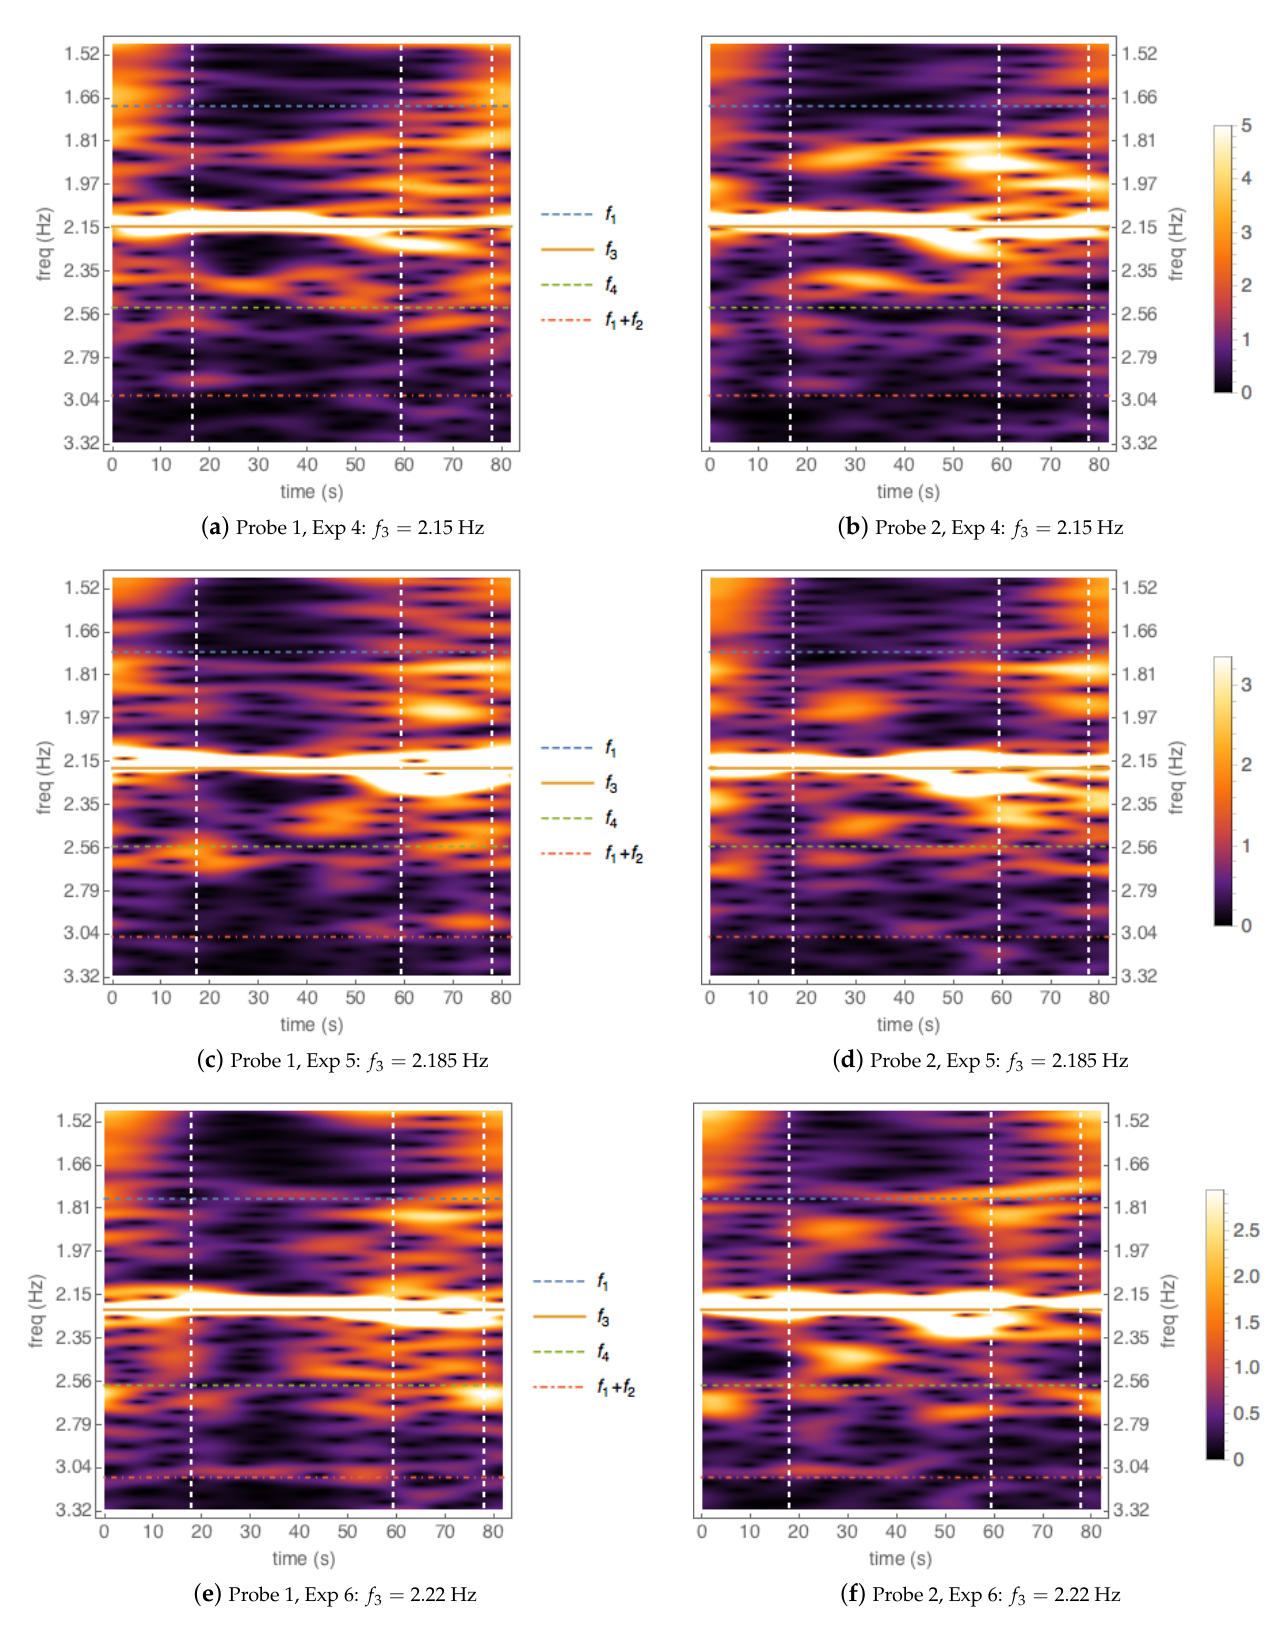
Figure 16. Same description as in the caption of Figure 15, but for experiments 4, 5 and 6, corresponding to f 3 / Hz = 2.15,2.185,2.22,